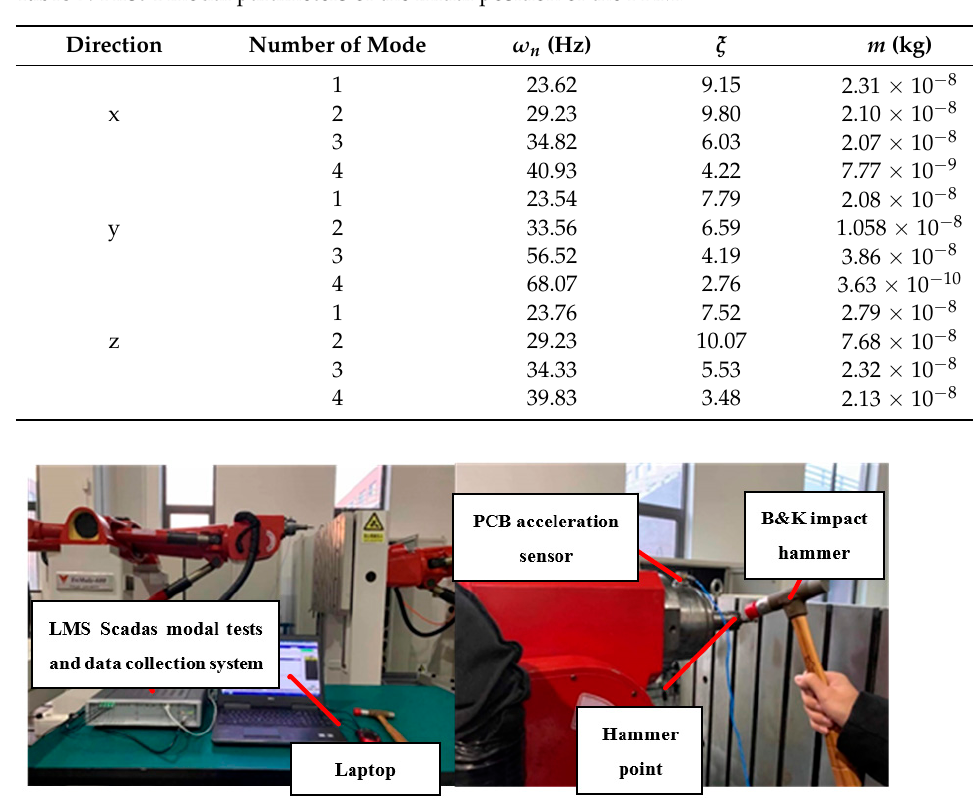
Table 7. First 4 modal parameters of the initial position of the PKM.